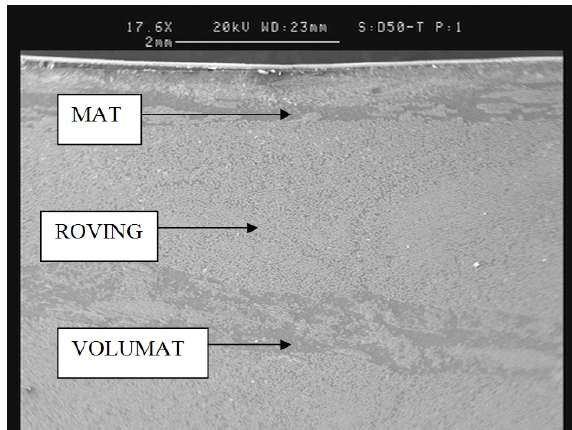
Figure 2: SEM micrograph showing Mat, Roving and Volumat